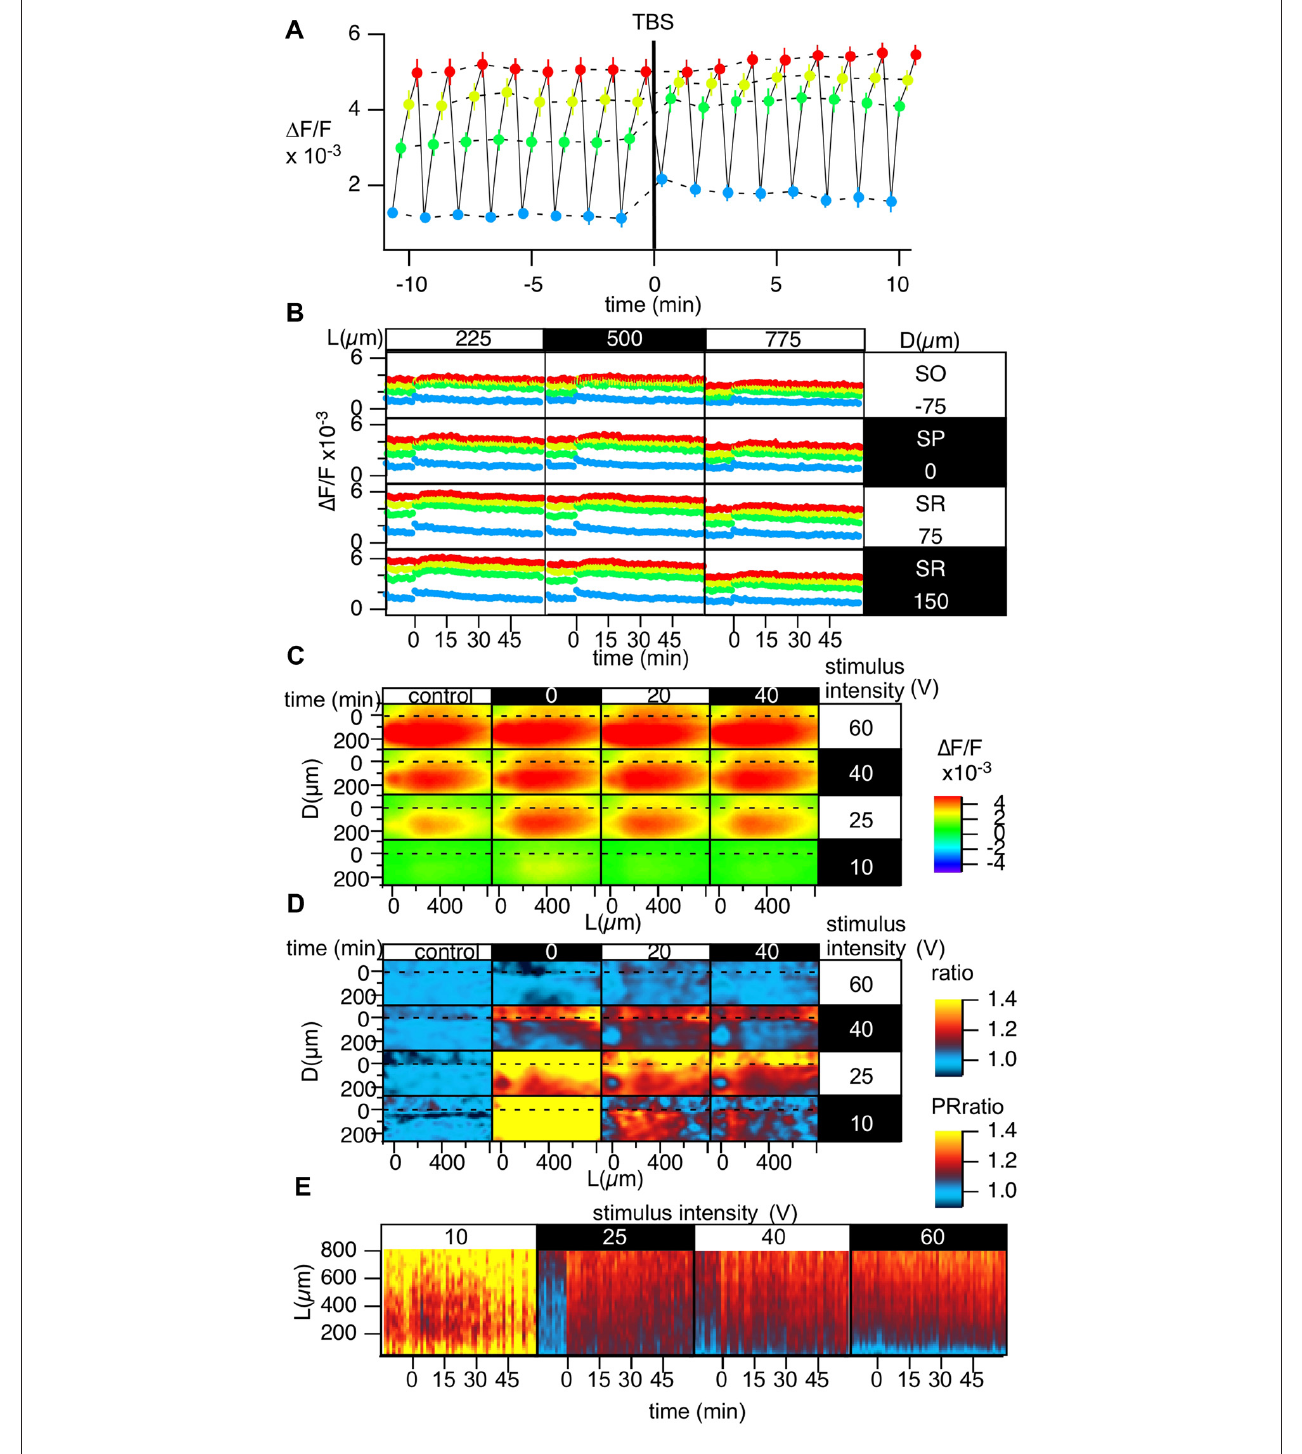
FIGURE 6 | Grouped data of the change in the stimulus-response relationship caused by TBS. (A) Change in the optically measured stimulus-response relationship measured by altering the stimulus intensity in four steps c[10 (blue), 25 (green), 40 (yellow) and 60 V (red)] every 20 s while performing optical recording in a time-window containing the induction of LTP in a representative point. (B) The time courses of the optical response at the representative points in the D-L coordinates while changing the stimulus intensity; the colors of the points correspond to the stimulus intensity [10 (blue), 25 (green), 40 (yellow), and 60 V (red)]. (C) The peak of the optical signals mapped in D-L coordinate at different stimulus intensity and different time. (D) The degree of LTP in the D-L coordinate plane corresponding to the stimulus intensity. (E) Time change in the PRR for each stimulus intensity. N = 2, n = 10, bars in (A,B) indicate SEM.